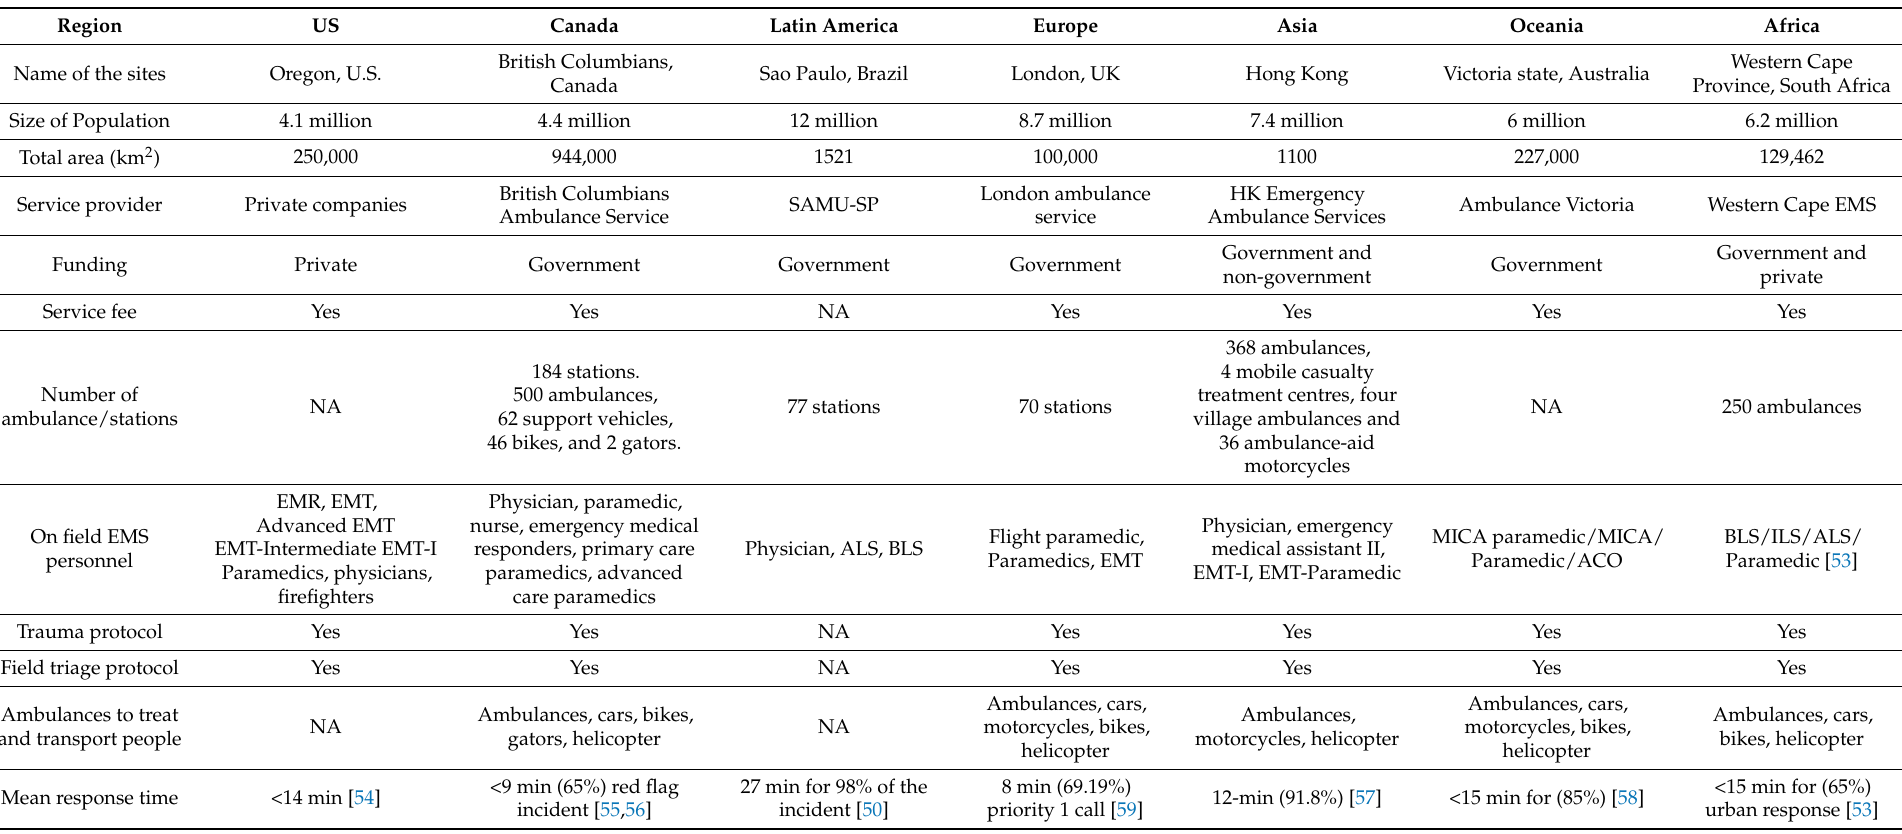
Table 4. Characteristics of prehospital trauma care system examples across the seven regions (from refereed literature and example Annual